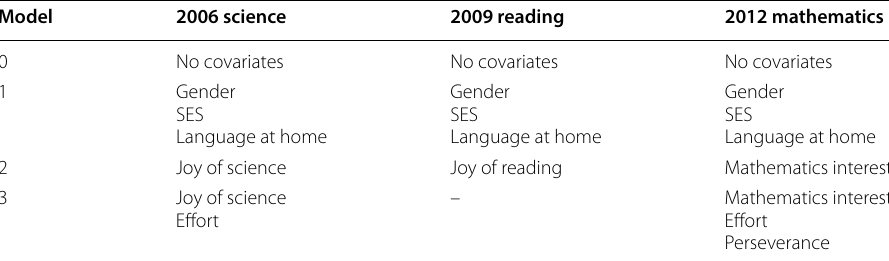
Table 3 Overview of the analysis scheme